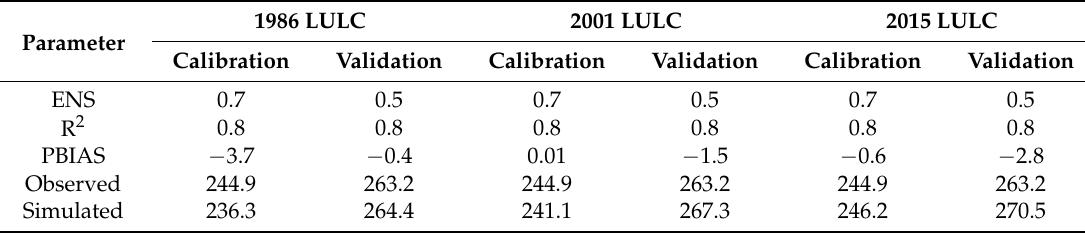
Table 4. Statistical values of ENS, R 2 and PBIAS (percent bias) during model calibration and validation under varying LULC during river discharge modeling.